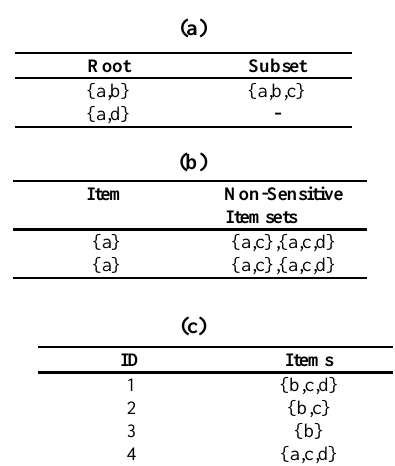
Table 4(a). Indexed sensitive itemsets, (b) Victim items list (vi-list), (c) Sanitized